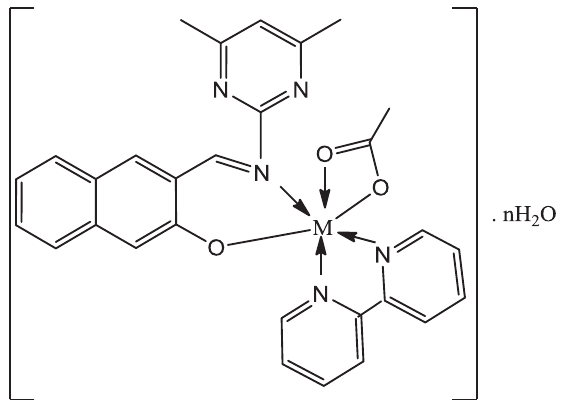
Figure 3 : Proposed structure of the metal(II)